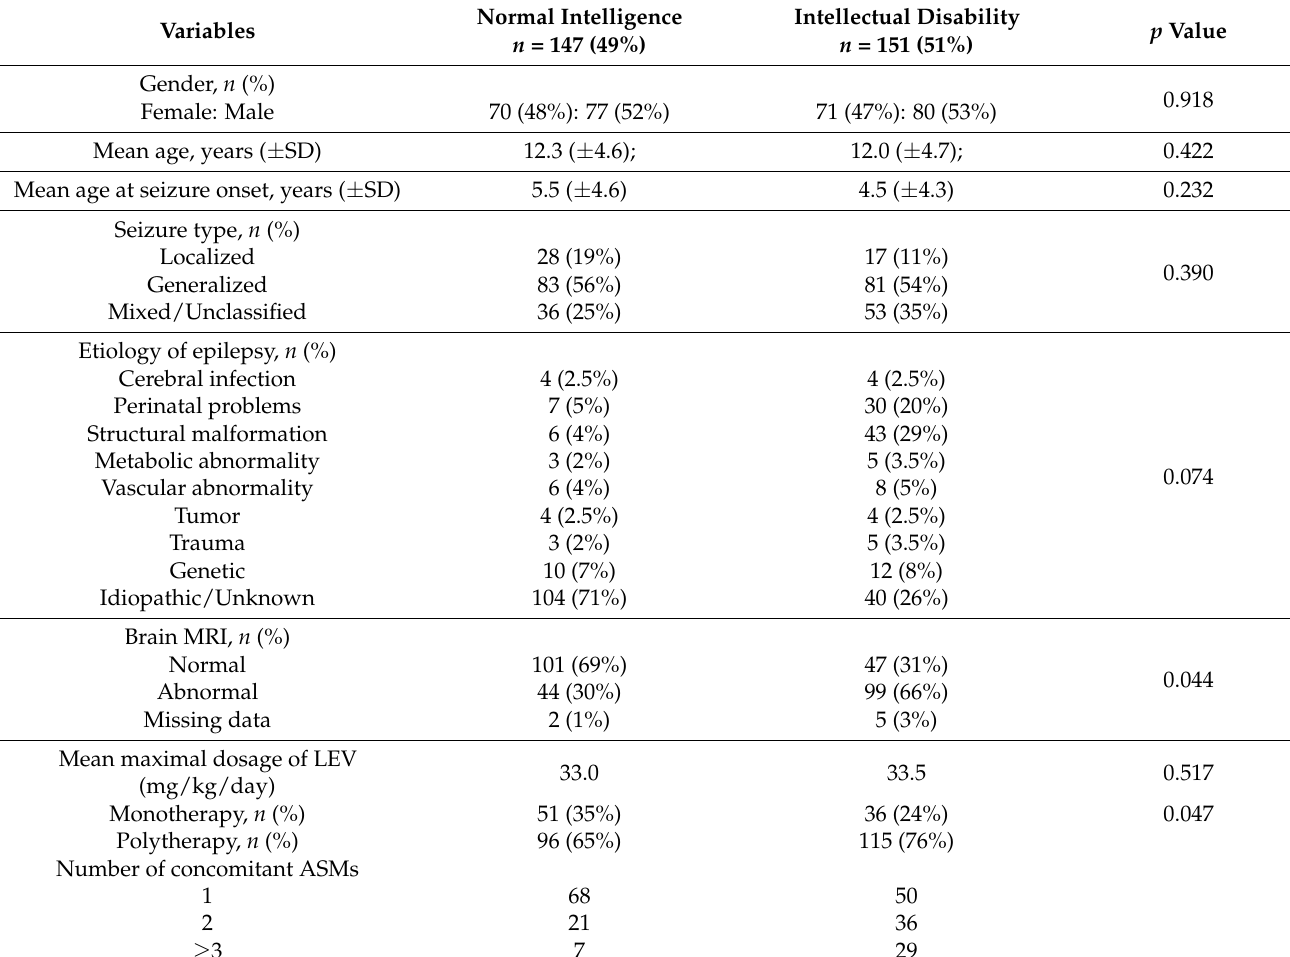
Table 1. Demographic and clinical